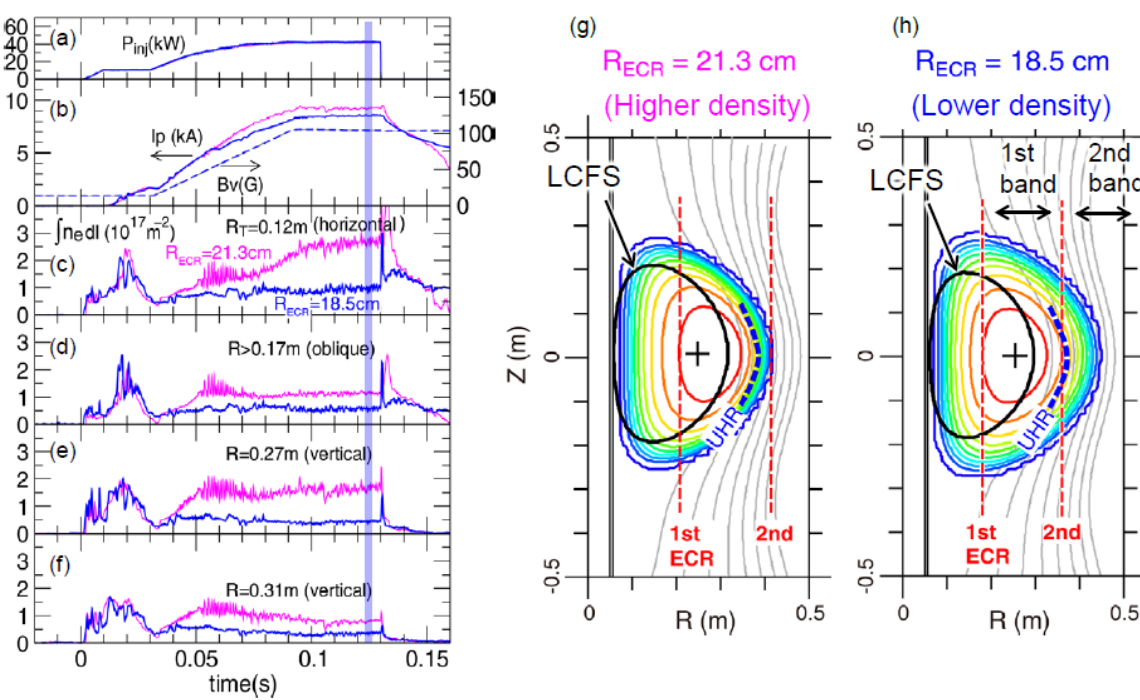
Figure 3. Discharges with R ECR = 18.5 cm (blue) and R ECR = 21.3 cm (magenta). Time traces of (a) injection power, (b) plasma current and vertical filed, (c) holizontal chord line-integrated density at a tangency radius of Rt = 12 cm, (d)-(f) oblique and vertical chord line-integrated density. Current density and poloidal flux contours with (g) R ECR = 18.5 cm and (h) R ECR = 21.3 cm at the final steady